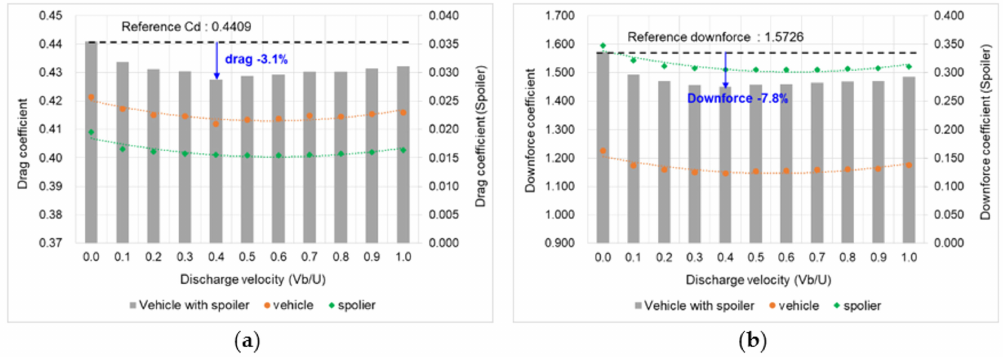
Figure 17. Comparison of aerodynamic coe ffi cients when flow discharge occurs at 0.75C at a vehicle driving speed of 300 km /